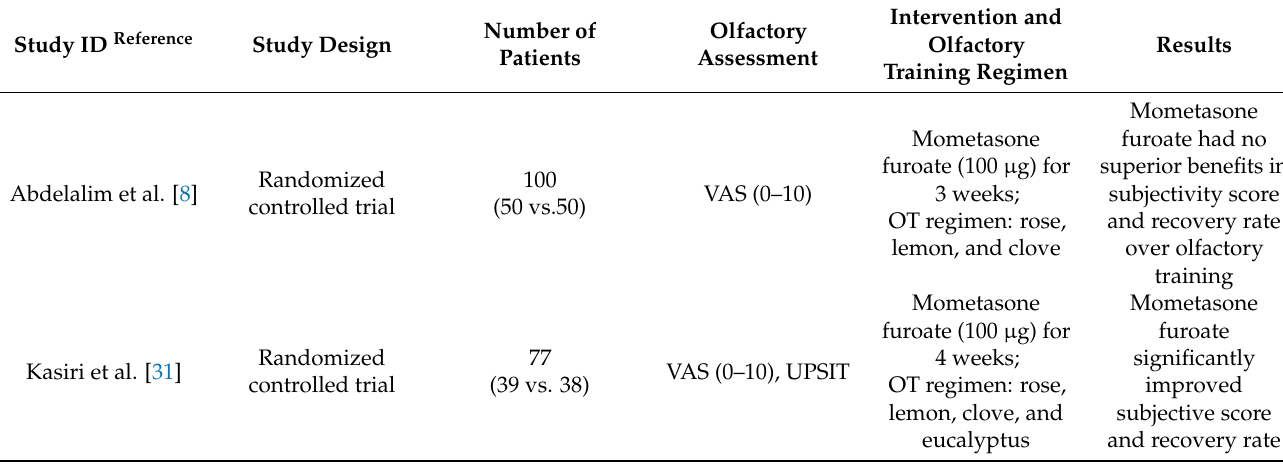
Table 2. Assessment of olfactory improvement according to additional intranasal steroid application with olfactory